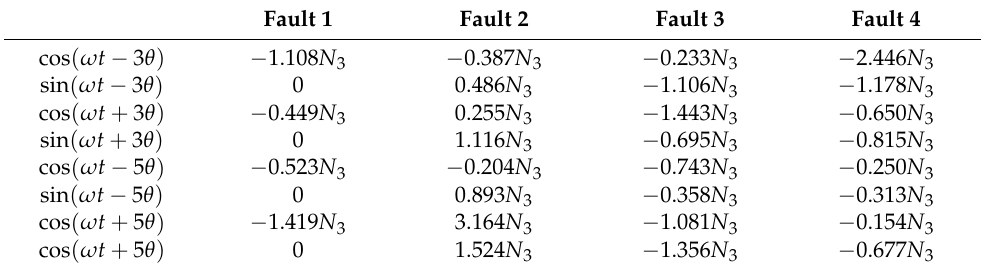
Table 2. Principle of equal magnitude of the residual phase currents.